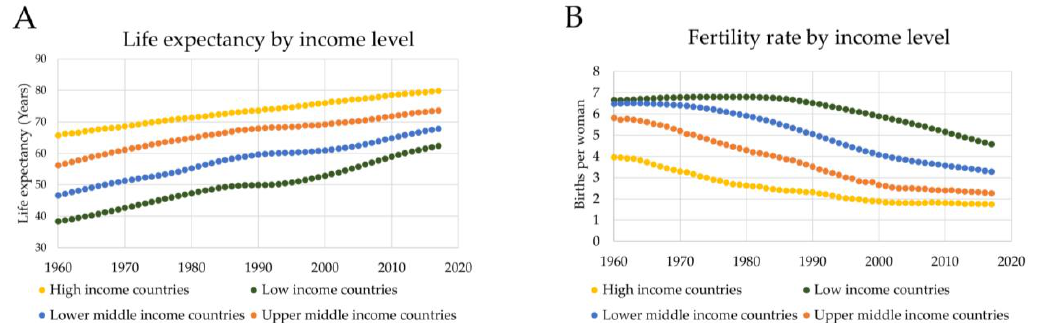
Figure 2. Life expectancy and fertility rates from 1960-2017 based on country income level. (A) Life expectancy per year by country income level [16]; (B) birth rates per year by country income level [17].